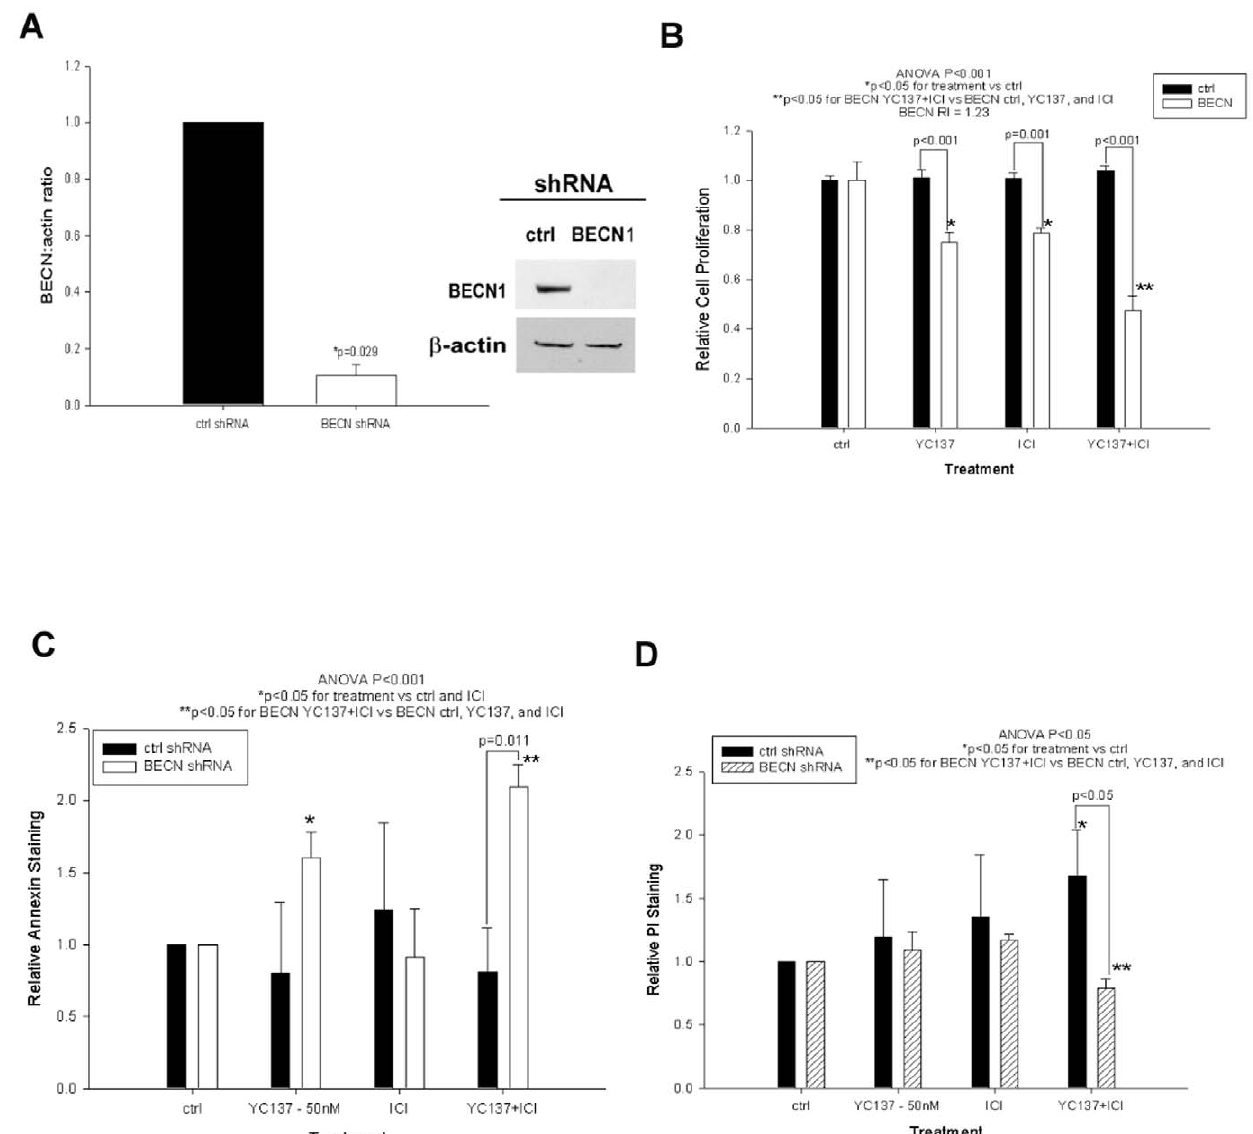
Figure 6. BECN1 knockdown and BCL-W/BCL2 co-inhibition decreases cell proliferation through increased apoptosis in resistant cells. ( A ) Whole cell lysates were subjected to Western blot analysis with a specific BECN1 monoclonal antibody. Bars represent the mean 6 SE of the relative BECN1:actin ratio (normalized to control cells) for three independent experiments. ( B ) shRNA infected MCF-7/LCC9 cells were treated with YC137 and/or ICI for 7-days. Bars represent the mean 6 SE of relative cell proliferation (normalized to EtOH treated controls) for a single representative experiment performed in triplicate. ( C ) shRNA infected MCF-7/LCC9 cells were treated with YC137, ICI, or a combination of YC137 and ICI. Bars represent the mean 6 SE of the relative Annexin V staining (normalized to empty vector controls) for three independent experiments. ( D ) Bars represent the mean 6 SE of the relative PI staining (normalized to empty vector controls) for three independent experiments.